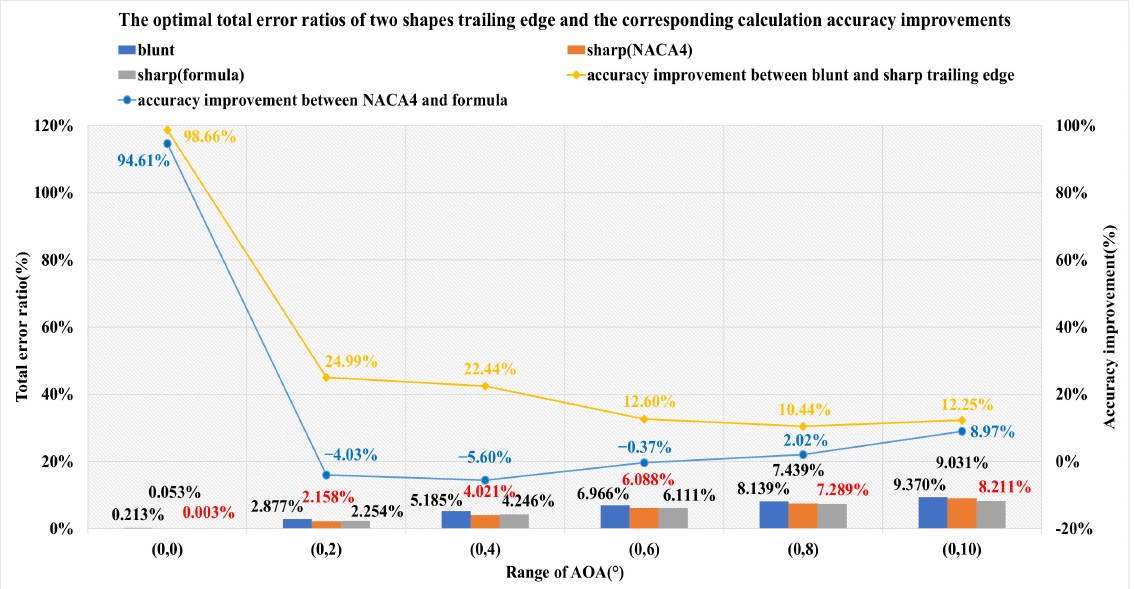
Figure 17. The optimal total error ratios of two shapes trailing edge and the corresponding calculation accuracy